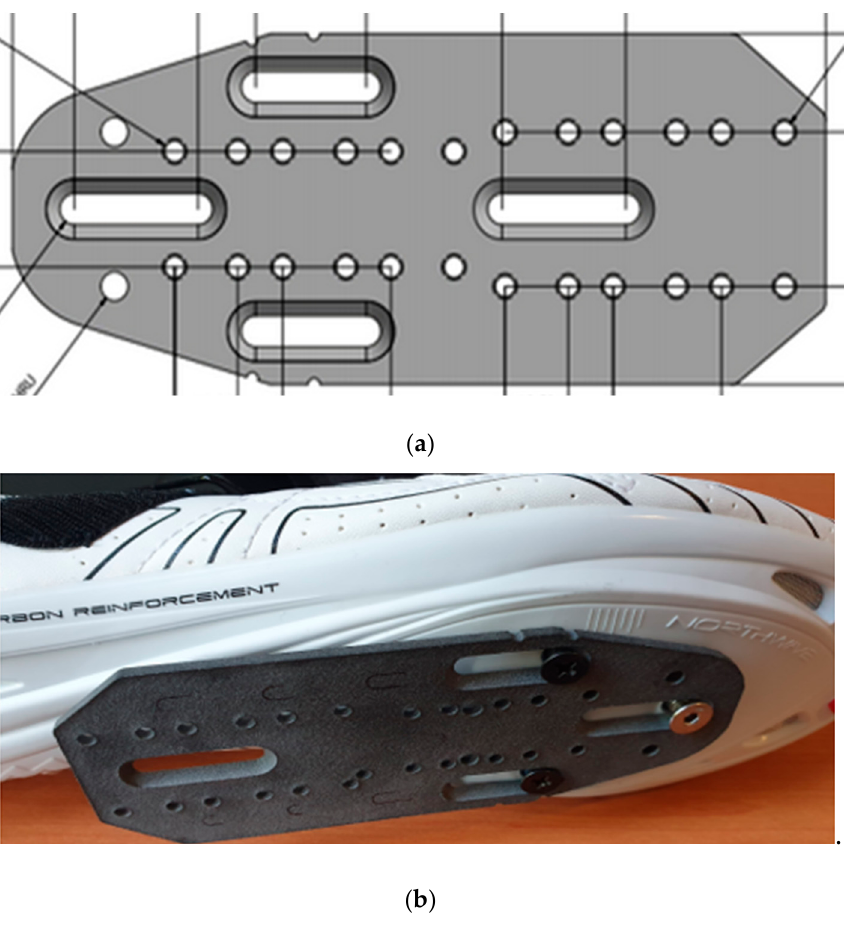
Figure 4. ( a ) Engineering CAD illustration including specifications and dimensions of aluminium bicycle cleat plate; ( b ) Prototype of cleat plate attached to cycling shoe. To accommodate the POS cleat location and modulate foot position, Northwave tri- sonic cycling shoes (Northwave, Via Levada, Pederobba TV, Italy) with Shimano SPD-SL pedals and yellow cleats with a tolerance of approximately 6 ◦ flotation and tension were used by all participants with the aluminium plate securely fastened (Figure 5). For both cleat conditions, participants were positioned with the following measurements: 30 ◦ knee flexion at point of terminal extension; anterior aspect of patella located vertically over the 3rd MPJ with the cranks in a horizontal position; and relative shoulder joint angle of approximately 90 ◦ . All measurements were made with a typical goniometer. To compensate for the effective decrease in leg length with the POS cleat position, the saddle height was positioned 5 mm lower [4].